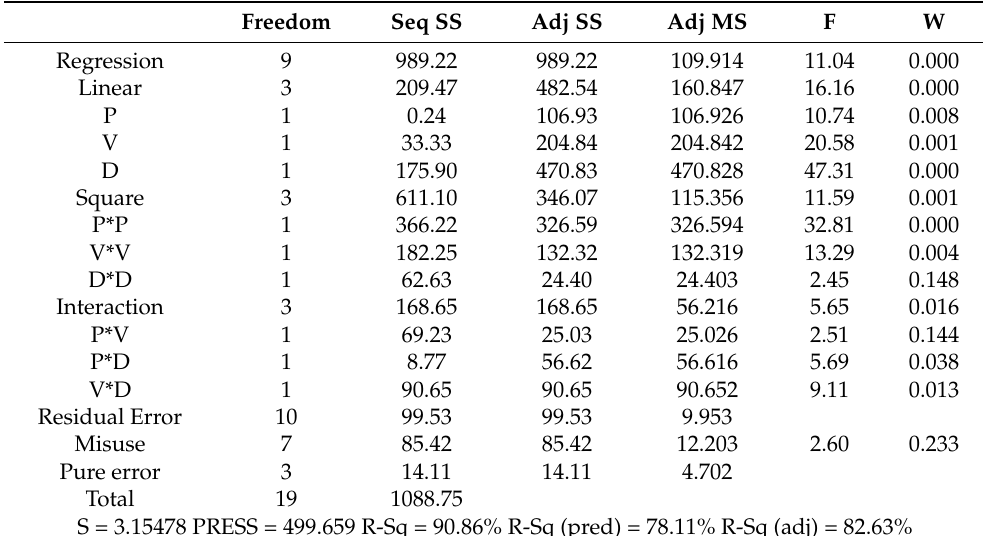
S = 3.15478 PRESS = 499.659 R-Sq = 90.86% R-Sq (pred) = 78.11% R-Sq (adj) =